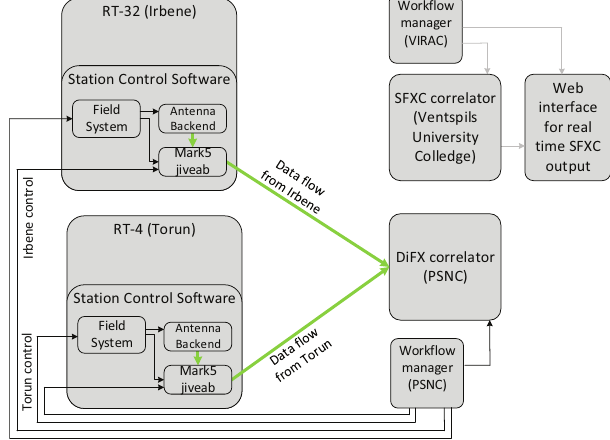
Fig. 7. An e-VLBI experiment. The data flow from the Torun RT-4 and the Irbene RT-32 radio telescopes has been processed in the PSNC DiXF correlator. The experiment was managed by a PSNC